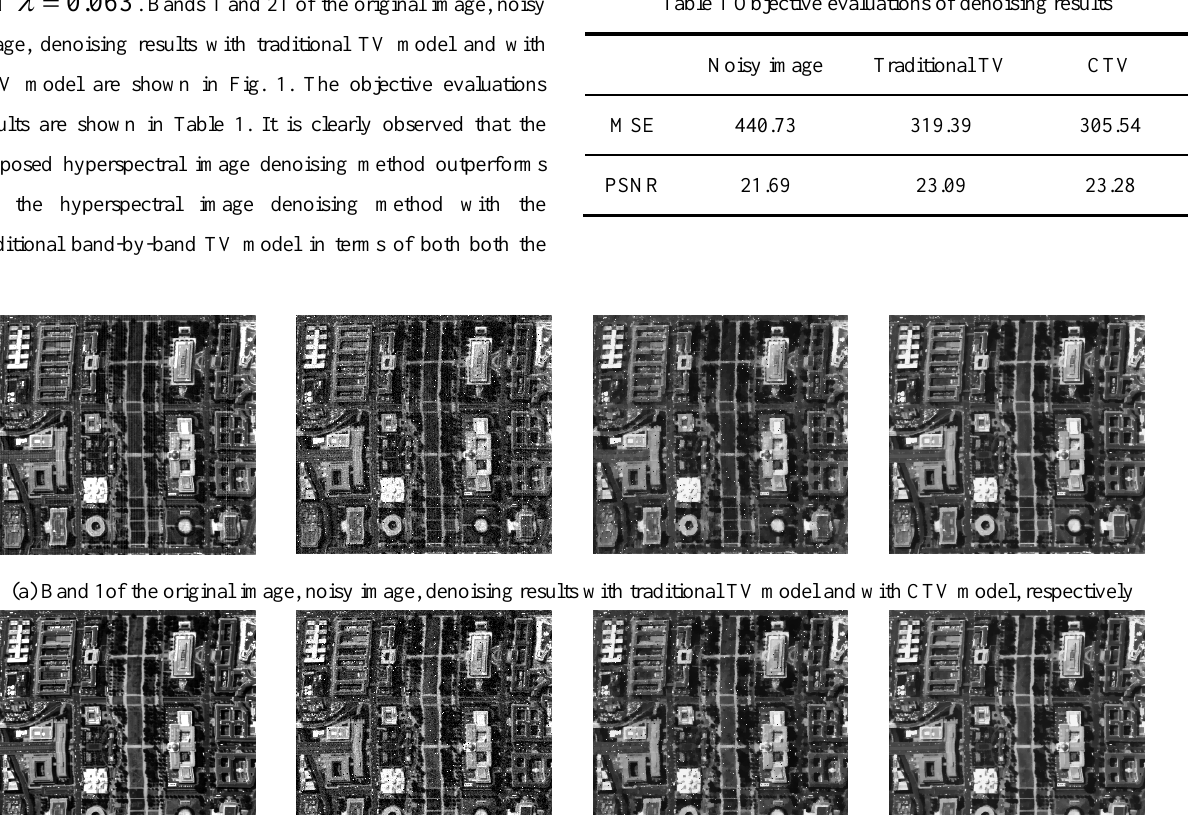
Table 1 Objective evaluations of denoising results